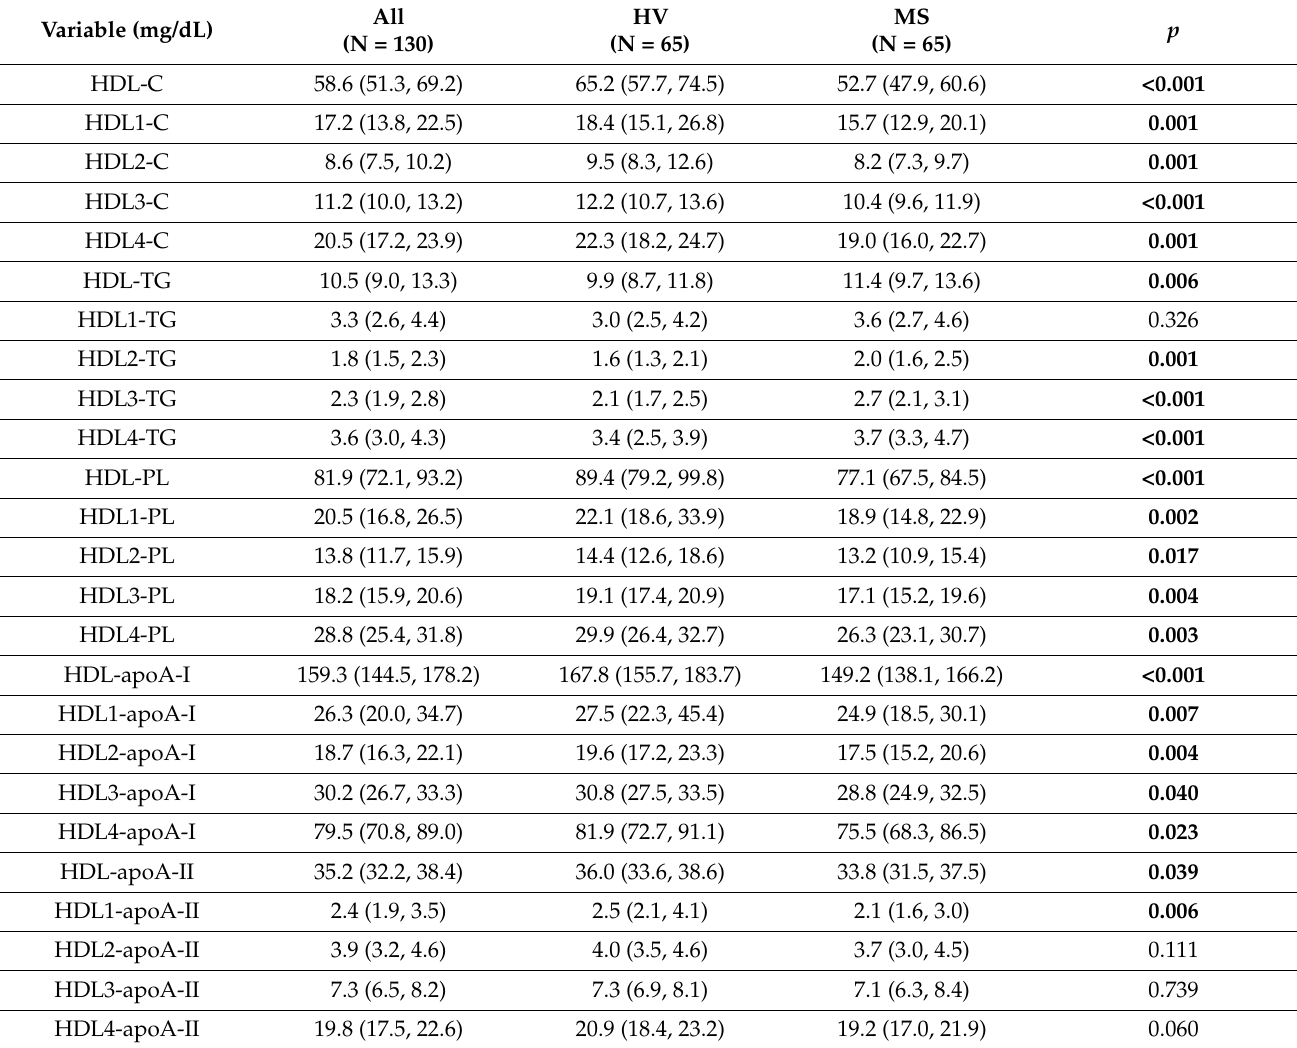
Table 3. Differences in serum levels of HDL subclasses between HV and MS